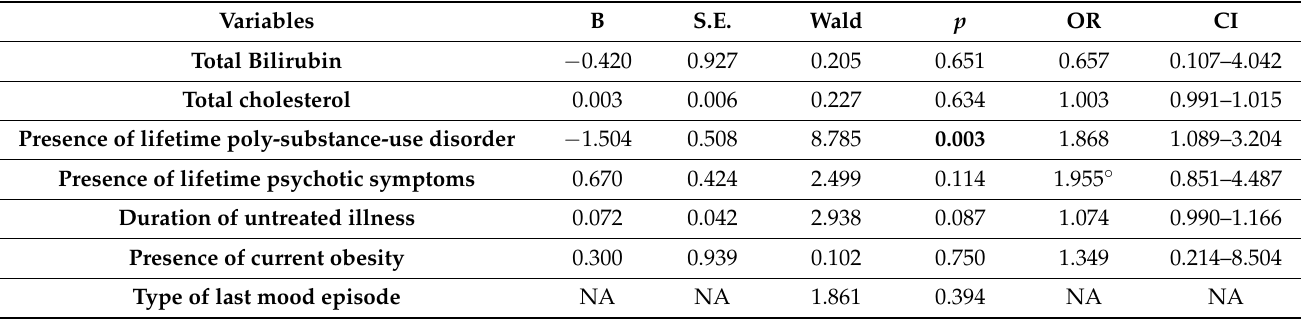
Table 4. Summary of the statistics for the best-fit multivariable logistic regression model